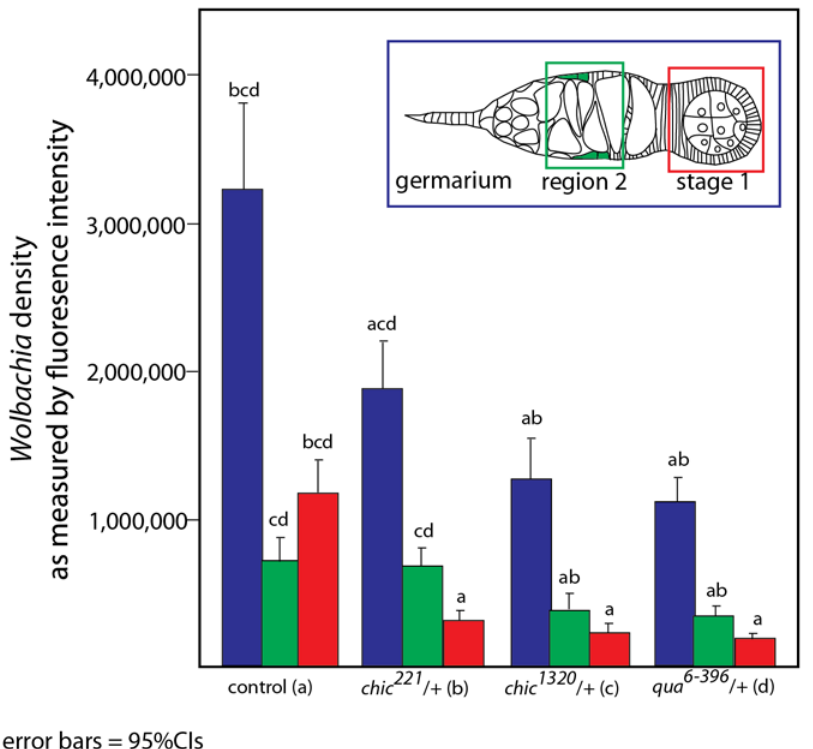
Fig 3. Quantification of reduction in Wolbachia titer during oogenesis, within the entire germarium (in blue), region 2, including the somatic stem cell niche (SSCN, green) and early egg chambers (stage 1, red). Flattened, maximum projections from z-sections were utilized to compare between control flies and chic 221 /+, chic 1320 /+ and qua 6-396 /+ F1 progeny stained with Hsp-60 for Wolbachia . Error bars = 95% confidence intervals and statistical significance in pairwise comparisons is shown above each bar (Kruskal Wallis tests followed by pairwise Mann-Whitney U tests between genotypes; p <